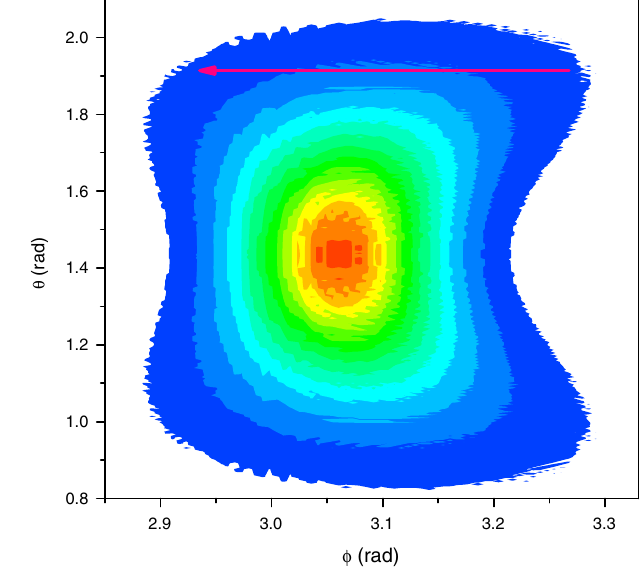
FIG. 5. (Color) The power density collected on a